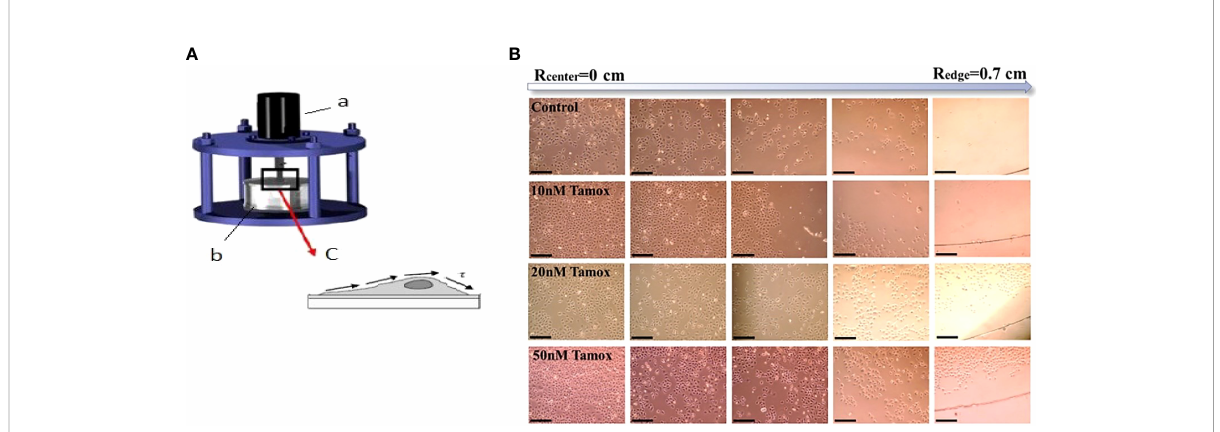
FIGURE 1 Estimation of adhesion forces by rotating disc assay. (A) The device consists of (a) rotor (b) tank fi lled with PBS at 37 °C, and (c) attached cancer cells on coverslips exhibiting shear stress ( t ) (16, 17). (B) MCF-7 cell detachment event in different distances from the center of the disc (Rcenter = 0) to the edge (Redge = 0.7 cm) and in different tamoxifen concentrations, black scale bar 100 m m, ×10 microscope lens. Cell detachment was less favored at the highest tamoxifen